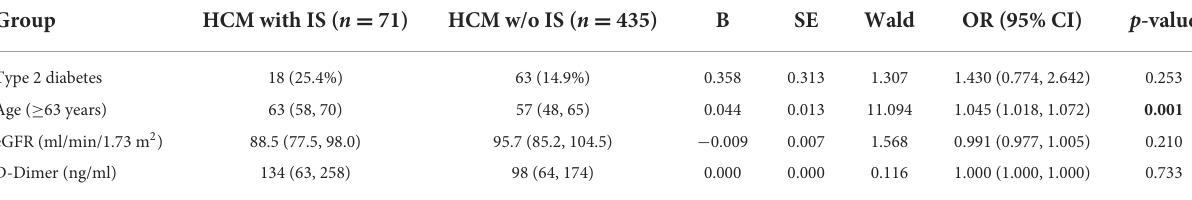
TABLE 2 Risk factors for ischemic stroke (IS) in patients with hypertrophic cardiomyopathy (HCM).